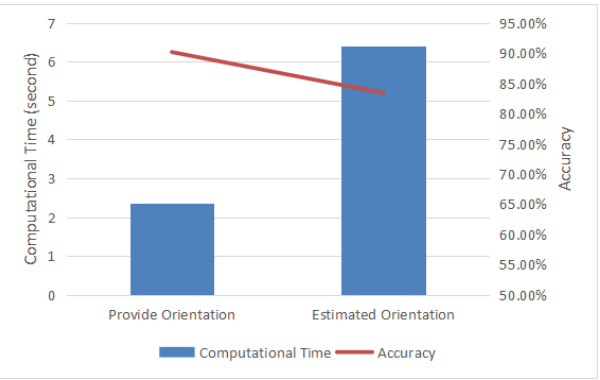
Figure 37. The effects of positioning accuracy and efficiency between estimating orientation and providing orientation.